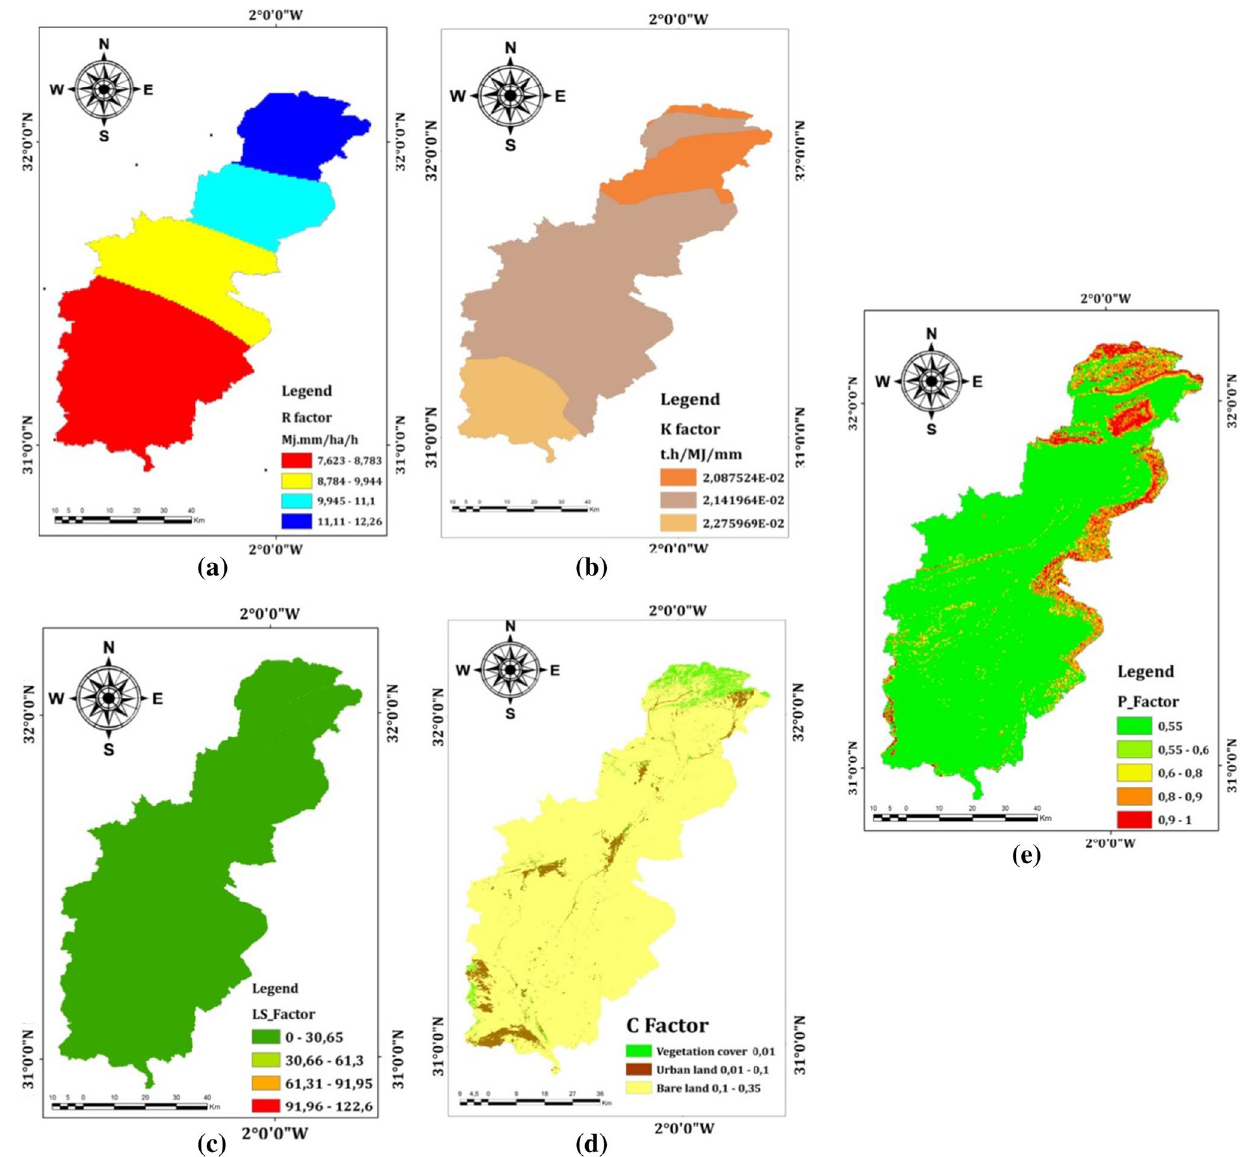
Fig. 2 USLE parameters a R factor map. b K factor map. c LS factor map. d C factor map. e P factor